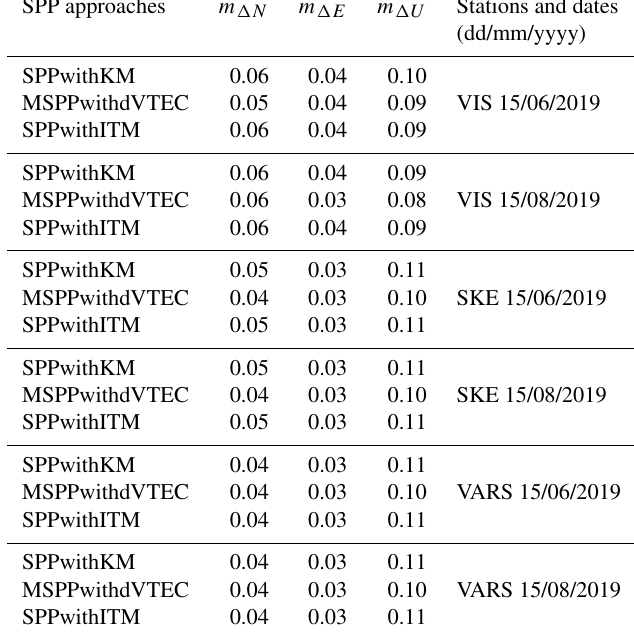
Table 3. Average errors of the difference in the positions using the NEU